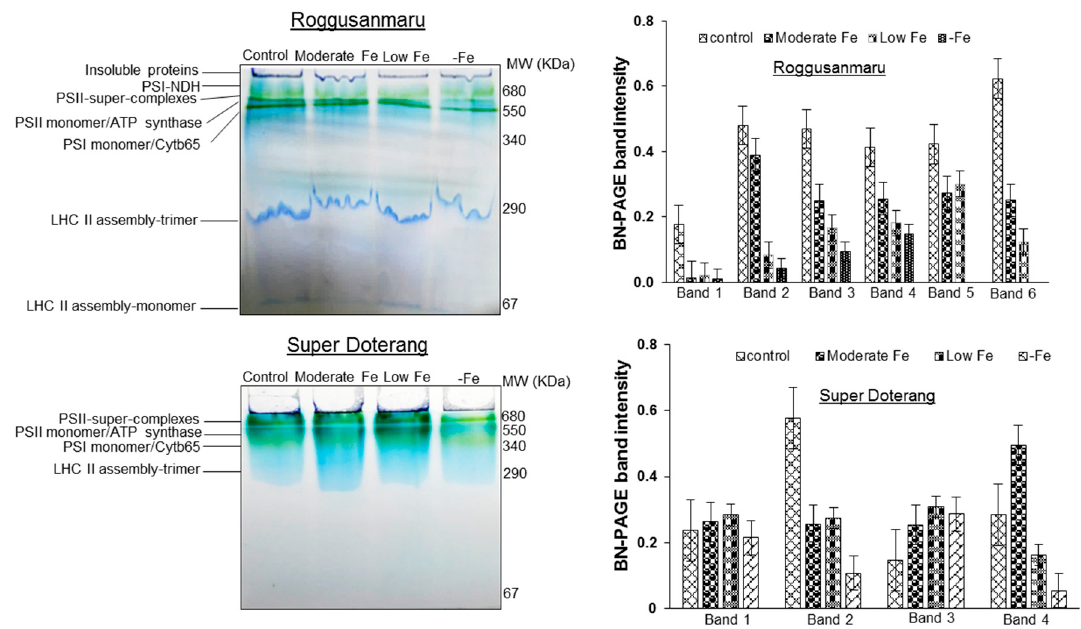
Figure 6. Multiprotein thylakoid membrane proteins (BN-PAGE) expressions and their band intensity in shoots of “Roggusanmaru” and “Super Doterang” tomato cultivar. Plants were grown in Fe-sufficient (control); moderate Fe; low Fe; and Fe-deficient (–Fe) Hoagland nutrient medium for 10 days. Proteins extracted from leaves were run on 7%–12% gradient polyacrylamide gel electrophoresis for blue native page (BN-PAGE). In bar diagram of “Roggusanmaru” Band 1 indicates Psi-NDH, Band 2 indicates PSII-super complexes, Band 3 indicates PSII monomer/ATP synthase, Band 4 indicates PSI monomer/Cytb65, Band 5 indicates LHC (light harvesting complex) II assembly-trimer and Band 6 indicates LHC II (light harvesting complex) assembly monomer. While in bar diagram of “Super Doterang” Band 1 indicates PSII-super complexes, Band 2 indicates PSII monomer/ATP synthase, Band 3 indicates PSI monomer/Cytb65 and Band 4 indicates LHC II (light harvesting complex) assembly-trimer (MW in figures denote molecular weight).